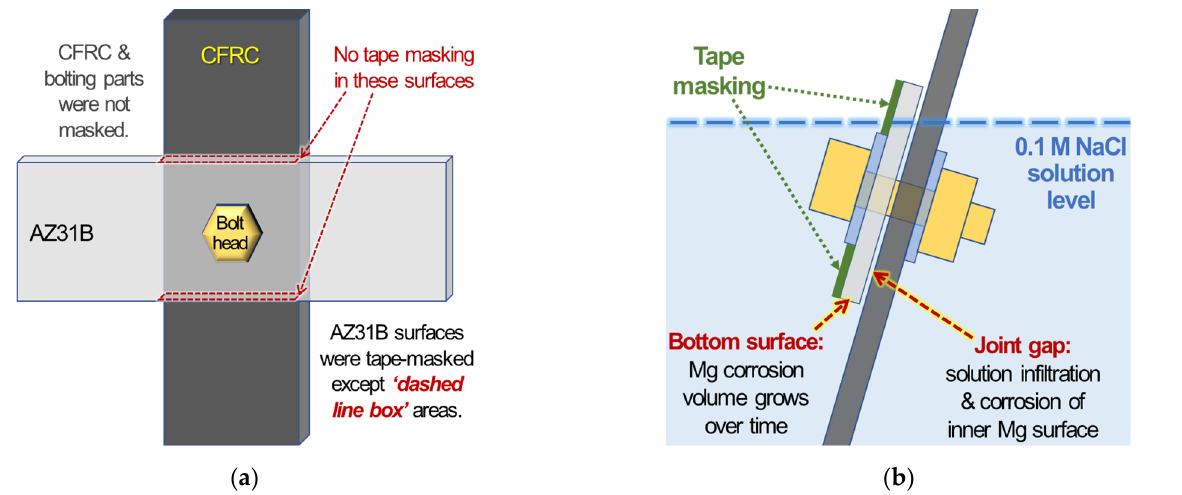
Figure 3. Schematics of ( a ) exposed AZ31B surfaces without tape masking in a cross-tension joint and ( b ) an immersed joint specimen with tape masking from the side view.